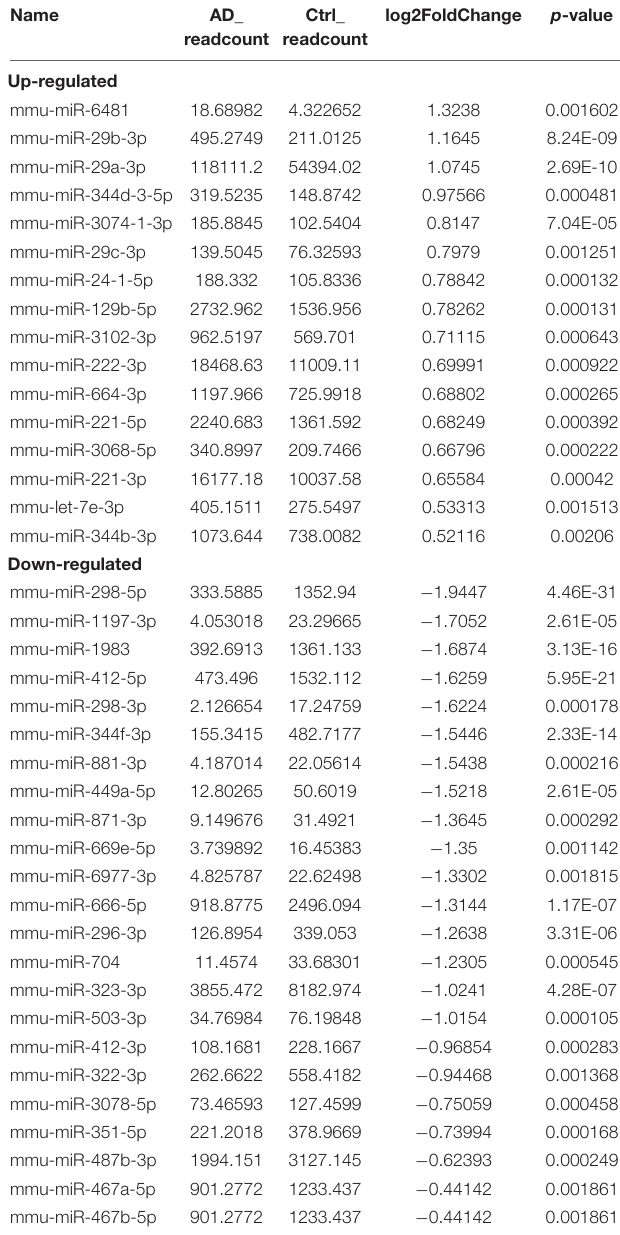
TABLE 2 | Differently expressed miRNAs between APP/PS1 and WT